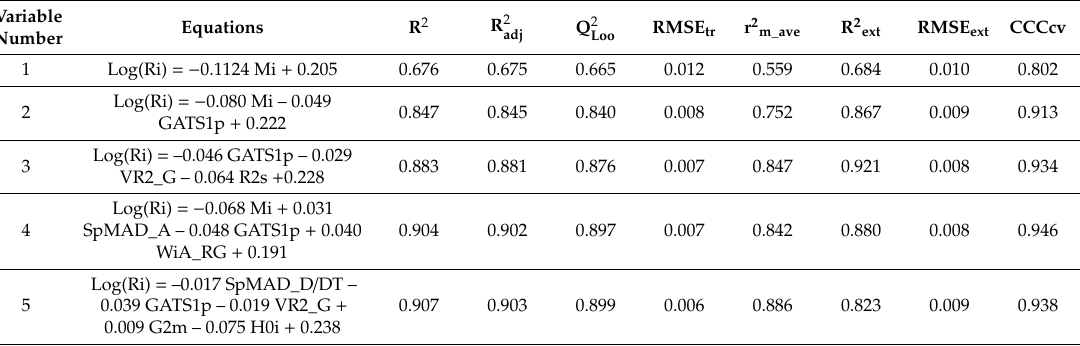
Table 1. List of the best models with 1–5 variables.